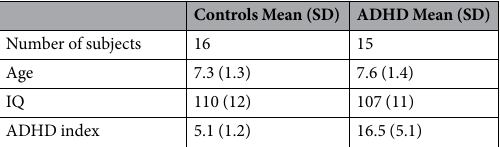
Table 2. Demographic data of subjects.